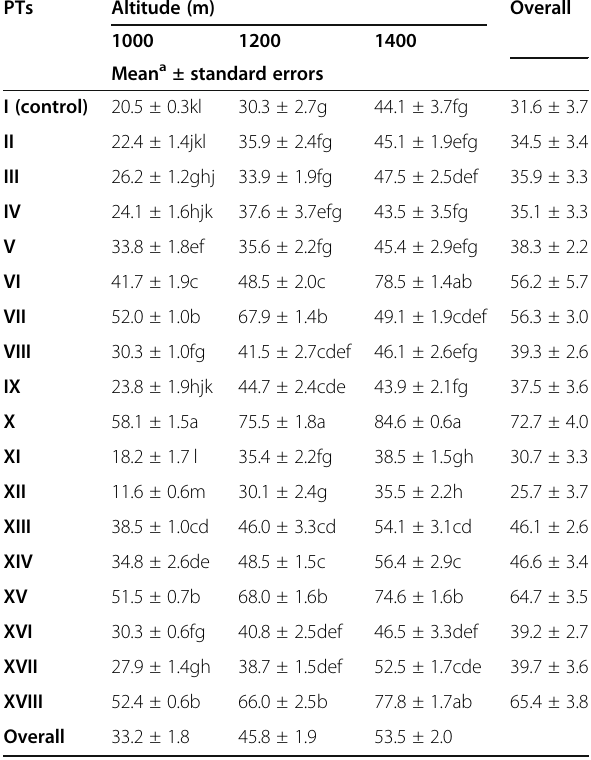
Table 2 Mean values and standard errors for percent emergence (%) of the seedlings for pretreatments (PTs) PTs Altitude (m)